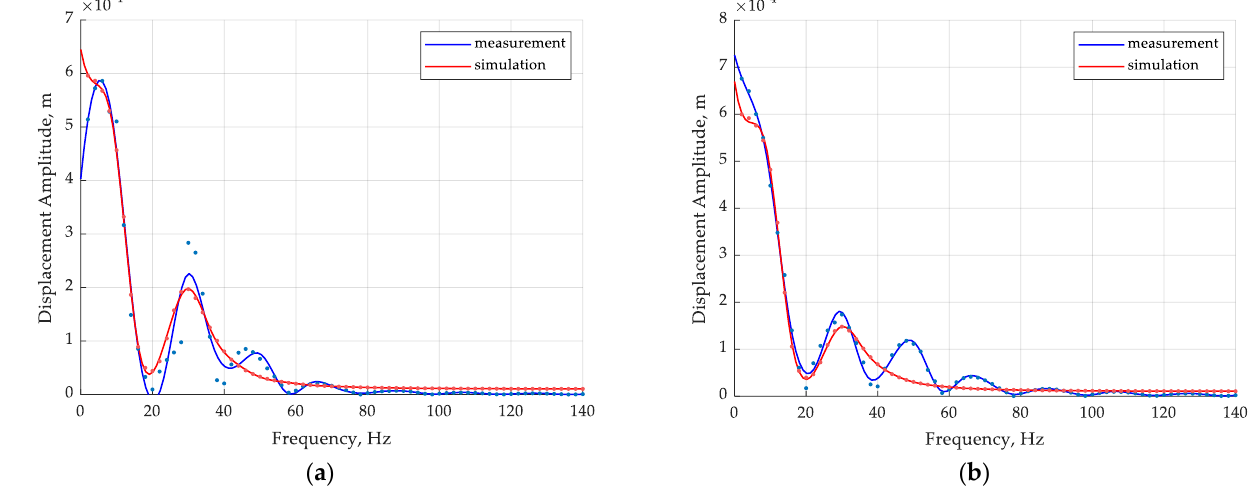
Figure 13. The amplitude as a function of the frequency of the measured and simulated vibration generator movement for constant input current ( a ) 0.35 A and ( b ) 0.75 A.